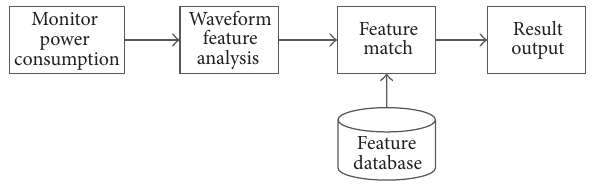
Figure 1: Malware detection